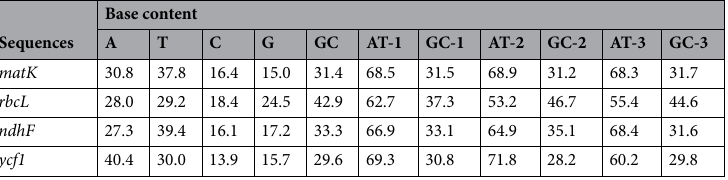
Table 1. The average number of identical pairs (ii) for candidate nucleotide sequences was showed in Table 2. The account of transitional pairs (si) and transversional pairs (sv) of nucleotide sequences was showed in Table 2. The transitional and transversional of bases in the sequences may be related to the species difference. Polymorphism site analysis of the candidate nucleotide sequences revealed in Table 3. Among the single sequence and the combination sequence rbcL sequence had the least proportion of mutation sites, accounting for 34.8%, while the conservative sites in the corresponding rbcL sequence accounted for 64.7%. The sequence matK had the highest proportion of mutation sites (70.2%), and the corresponding matK sequence had the lowest proportion of conservative sites (18.9%). Genetic diversity.